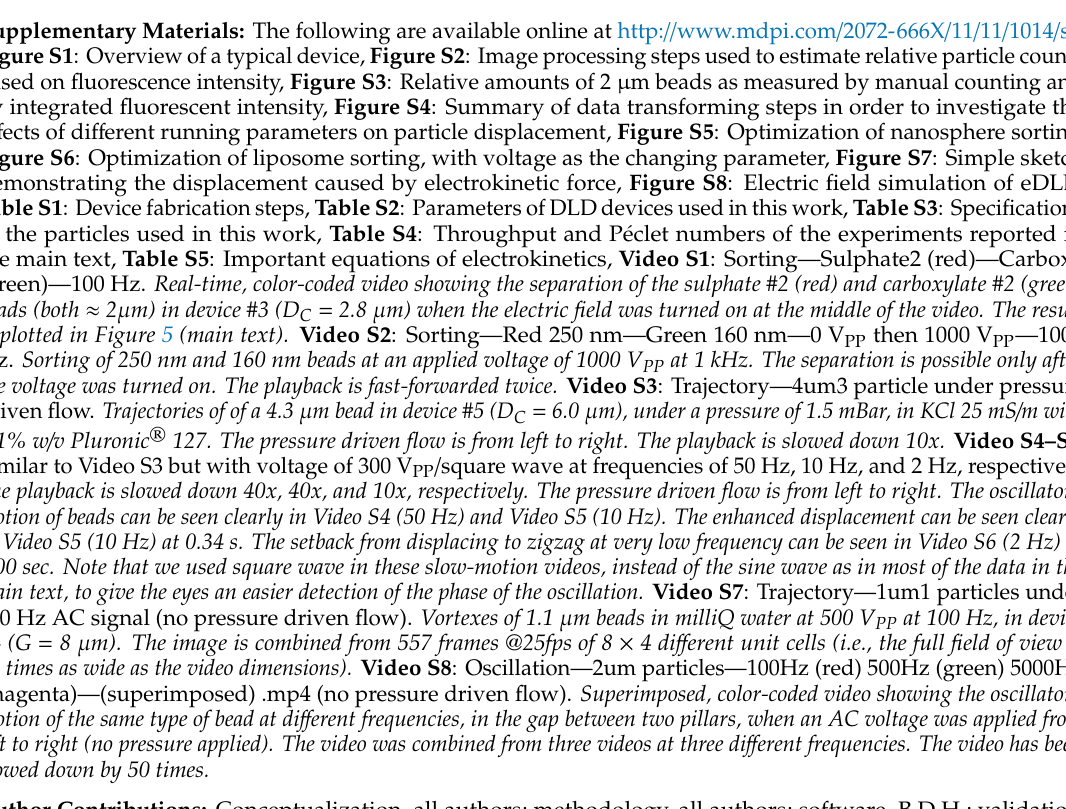
Figure S1 : Overview of a typical device, Figure S2 : Image processing steps used to estimate relative particle counts based on fluorescence intensity, Figure S3 : Relative amounts of 2 µ m beads as measured by manual counting and by integrated fluorescent intensity, Figure S4 : Summary of data transforming steps in order to investigate the e ff ects of di ff erent running parameters on particle displacement, Figure S5 : Optimization of nanosphere sorting, Figure S6 : Optimization of liposome sorting, with voltage as the changing parameter, Figure S7 : Simple sketch demonstrating the displacement caused by electrokinetic force, Figure S8 : Electric field simulation of eDLD, Table S1 : Device fabrication steps, Table S2 : Parameters of DLD devices used in this work, Table S3 : Specifications of the particles used in this work, Table S4 : Throughput and P é clet numbers of the experiments reported in the main text, Table S5 : Important equations of electrokinetics, Video S1 : Sorting—Sulphate2 (red)—Carbox2 (green)—100 Hz. Real-time, color-coded video showing the separation of the sulphate #2 (red) and carboxylate #2 (green) beads (both ≈ 2 µ m) in device #3 (D C = 2.8 µ m) when the electric field was turned on at the middle of the video. The result is plotted in Figure 5 (main text). Video S2 : Sorting—Red 250 nm—Green 160 nm—0 V PP then 1000 V PP —1000 Hz. Sorting of 250 nm and 160 nm beads at an applied voltage of 1000 V PP at 1 kHz. The separation is possible only after the voltage was turned on. The playback is fast-forwarded twice. Video S3 : Trajectory—4um3 particle under pressure driven flow. Trajectories of of a 4.3 µ m bead in device #5 (D C = 6.0 µ m), under a pressure of 1.5 mBar, in KCl 25 mS / m with 0.1% w / v Pluronic ® 127. The pressure driven flow is from left to right. The playback is slowed down 10x. Video S4–S6 : Similar to Video S3 but with voltage of 300 V PP / square wave at frequencies of 50 Hz, 10 Hz, and 2 Hz, respectively. The playback is slowed down 40x, 40x, and 10x, respectively. The pressure driven flow is from left to right. The oscillatory motion of beads can be seen clearly in Video S4 (50 Hz) and Video S5 (10 Hz). The enhanced displacement can be seen clearly in Video S5 (10 Hz) at 0.34 s. The setback from displacing to zigzag at very low frequency can be seen in Video S6 (2 Hz) at 1.00 sec. Note that we used square wave in these slow-motion videos, instead of the sine wave as in most of the data in the main text, to give the eyes an easier detection of the phase of the oscillation. Video S7 : Trajectory—1um1 particles under 100 Hz AC signal (no pressure driven flow). Vortexes of 1.1 µ m beads in milliQ water at 500 V PP at 100 Hz, in device #4 (G = 8 µ m). The image is combined from 557 frames @25fps of 8 × 4 di ff erent unit cells (i.e., the full field of view is 32 times as wide as the video dimensions). Video S8 : Oscillation—2um particles—100Hz (red) 500Hz (green) 5000Hz (magenta)—(superimposed) .mp4 (no pressure driven flow). Superimposed, color-coded video showing the oscillatory motion of the same type of bead at di ff erent frequencies, in the gap between two pillars, when an AC voltage was applied from left to right (no pressure applied). The video was combined from three videos at three di ff erent frequencies. The video has been slowed down by 50